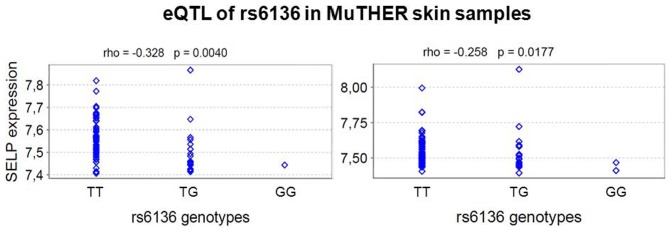
Cis-eQTL for rs6136 in the SELP gene in skin tissue from two sets of twins.Data were derived from The MuTHER Study [37] and analyzed by applying Genevar 3.5.0. These data successfully replicated DAE for rs6136. The two diagrams represent results from two skin sample groups derived from 76 and 84 female twins.